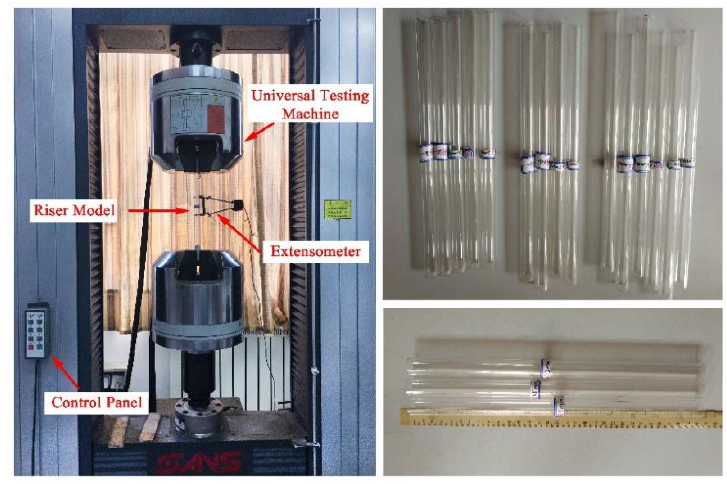
Figure 4. Experimental model and mechanical properties test. Table 1. Detailed parameters of the riser.